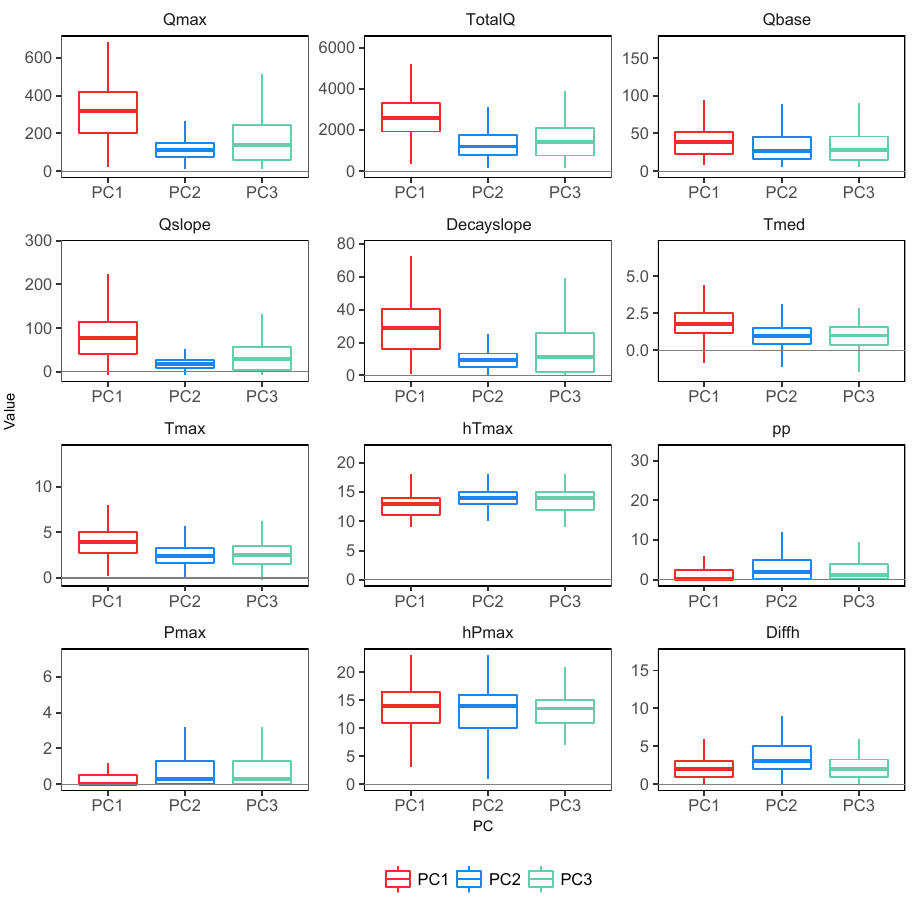
Figure 5. Summary of the frequency distributions (box plots) of the hydrological and meteorological indicators for days grouped within PC1, PC2 and